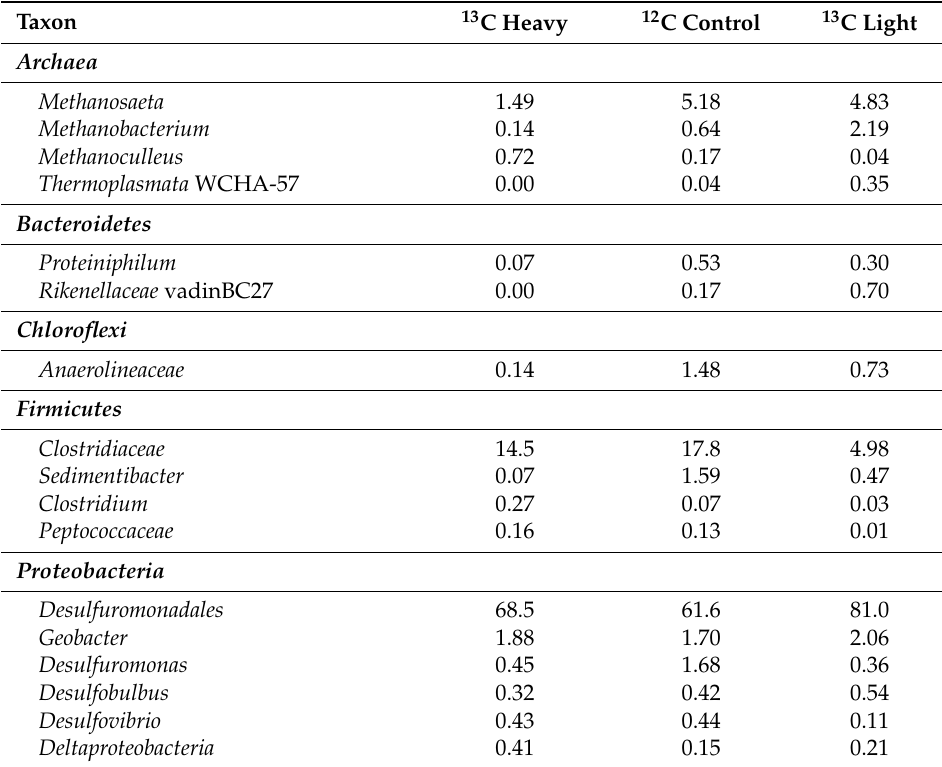
Figure 4. Relative distribution of total 16S rRNA gene fragments in NDC SIP fractions containing 13 C- and 12 C-DNA extracted after 60 days of incubation. The red shaded area indicates fractions considered to be enriched in 13 C-DNA compared to background 12 C-DNA microorganisms (shaded area in blue) and were predicted to harbor naphthalene degraders. Fractions chosen and pooled for metagenomic sequencing analysis are indicated with arrows. Table 1. Distribution of the most abundant classified taxa (%) across SIP fractions collected after 60 days of incubation, as determined by 16S rRNA gene sequencing